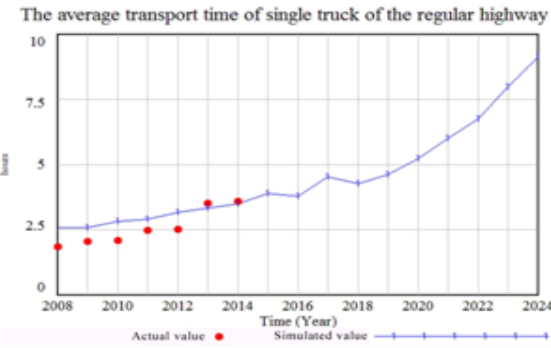
Figure 4. Model validation on the average transport time of a single truck using the regular